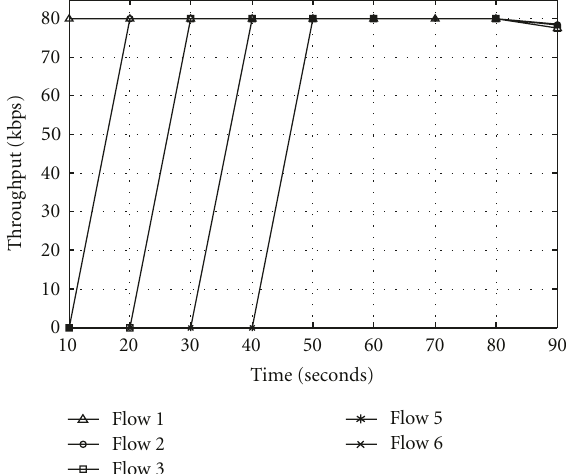
Figure 11: Throughput of five flows versus time when IAC/O is employed. RTS/CTS mechanism is used.